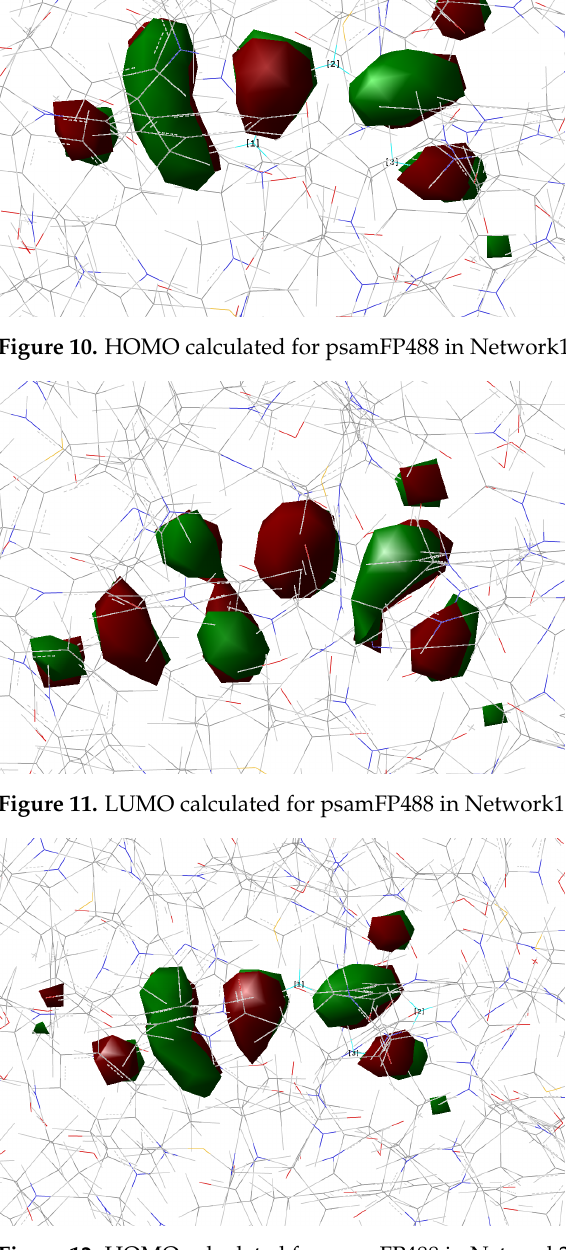
Figure 12. HOMO calculated for psamFP488 in